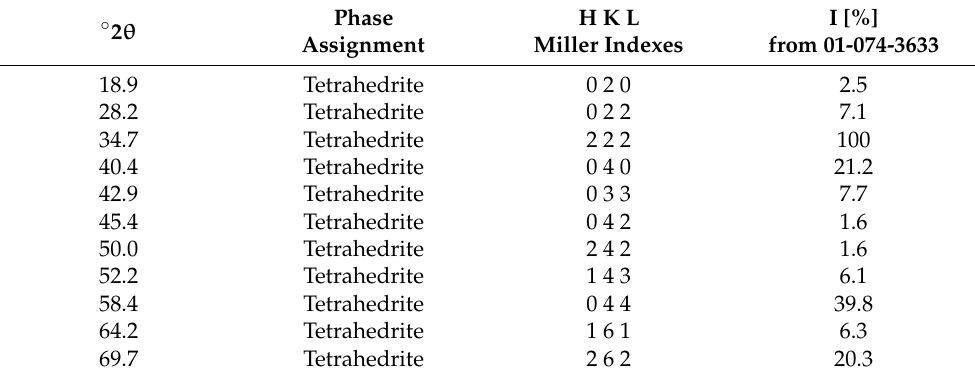
Figure 11. PLS regression coefficients for antimony concentration in concentrates. The coefficients identify the parts of the diffractogram contributing most to the PLSR regression model. Table 4. 2theta angles in the diffraction pattern of copper concentrates with the highest regression coefficient for the PLSR model of antimony, and diffraction peaks of the corresponding phase.